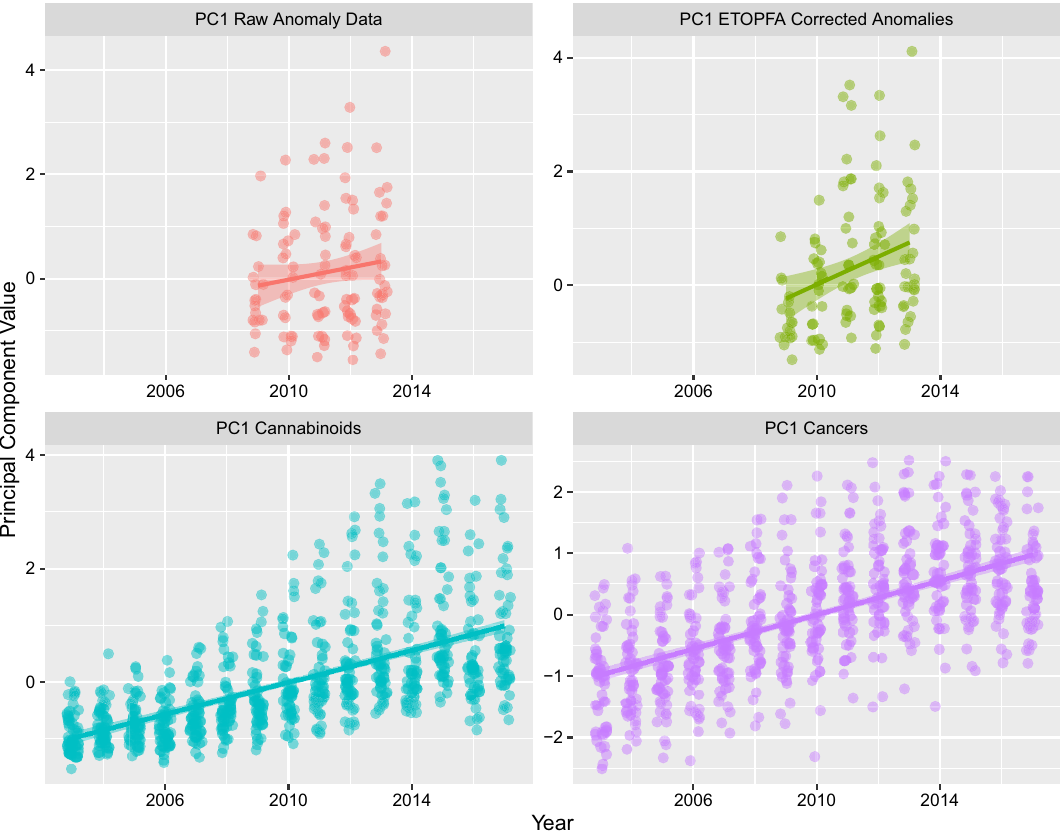
Figure 3. The time course of the four PC1’s for: CAR, ETOPFACAR, cannabinoids and Cancer data (Created in R-Studio version 1.3.1093 using ggplot2 version